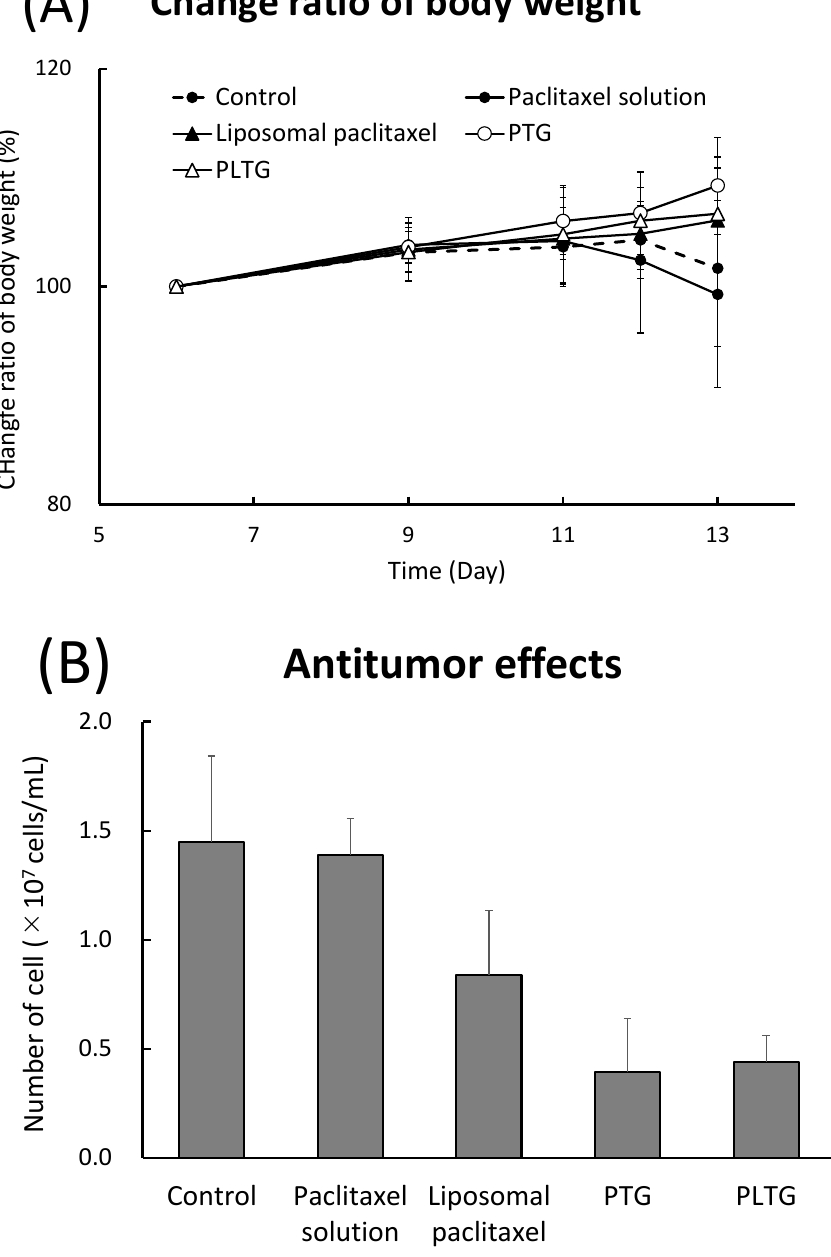
Figure 5. Antitumor effect on a mouse model of peritoneal dissemination. ( A ) Change in body weight. The bodyweight of all mice was measured during the test period. ( B ) The antitumor effect as the number of cells grown in the mouse abdominal cavity. Paclitaxel solution, liposomal paclitaxel, PTG, and PLTG were administered intraperitoneally 6, 9, and 12 days after transplantation of M5076 ovarian sarcoma cells into the abdominal cavity, respectively. At 13 days after transplantation, the cell suspension in the abdominal cavity was collected, and the viable cell count was counted using a hemocytometer. Data are expressed as the mean ± SEM of n = 5–7. Significant differences from Control, Paclitaxel solution, and Liposomal paclitaxel are (a) p < 0.01, (b) p < 0.001, and (c) p < 0.05,